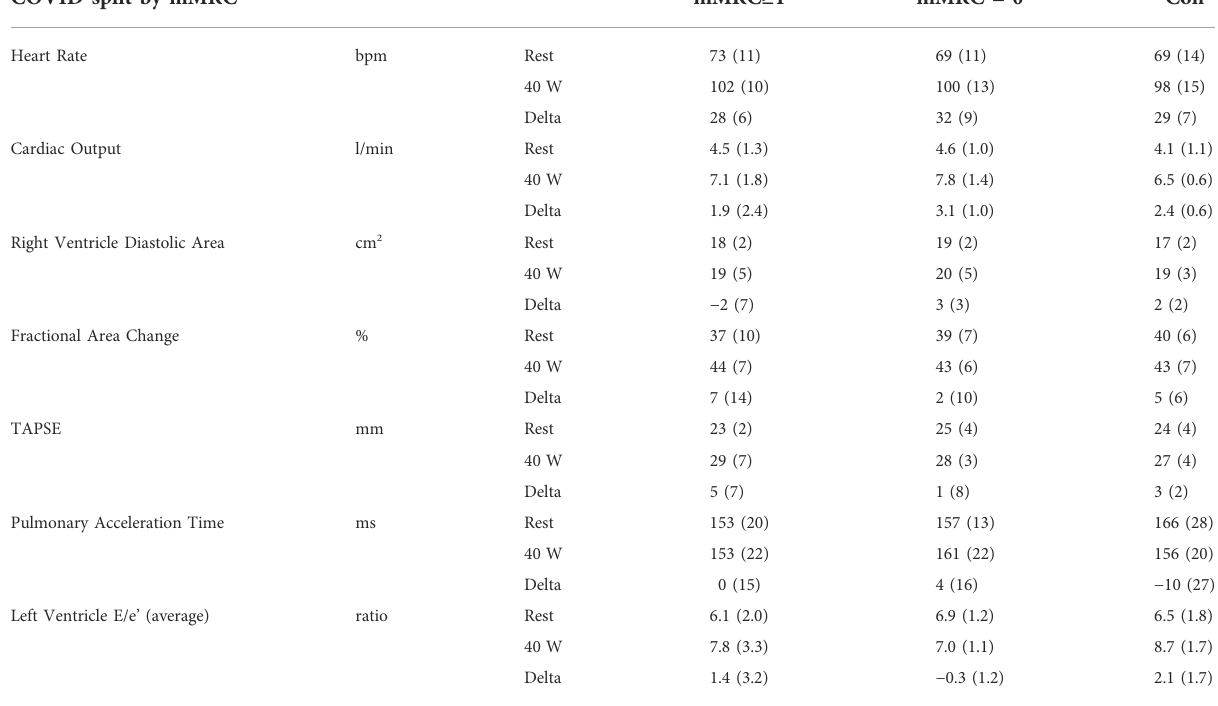
TABLE 6 Rest and exercise (40 W) echocardiography data for mMRC ≥ 1 (dyspneic-CoV), mMRC = 0 and Controls. TAPSE, tricuspid annular plane systolic excursion. COVID split by